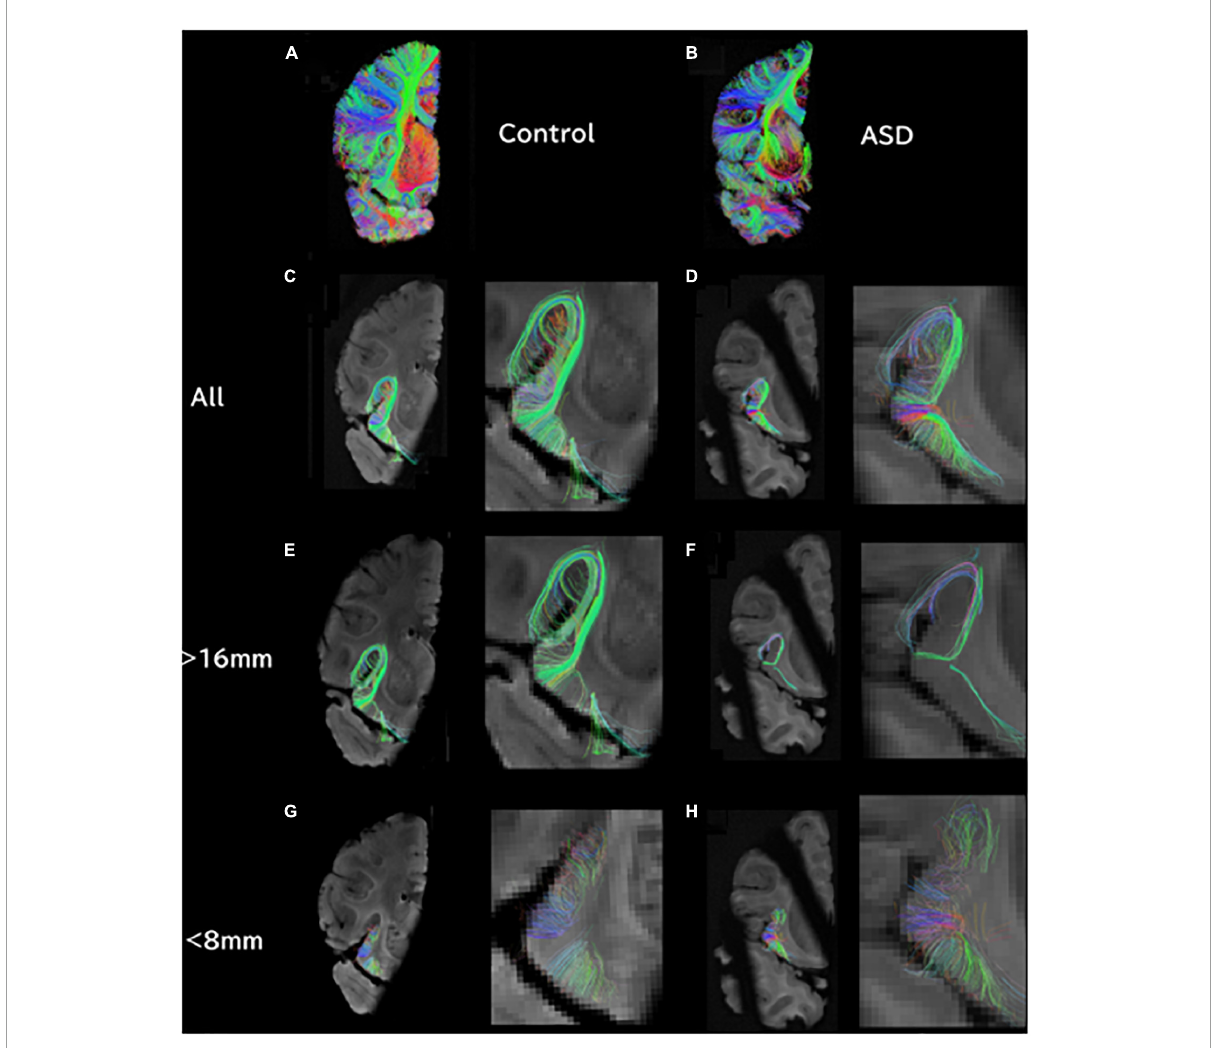
FIGURE1 At the level of the insula/thalamus, longer tractography pathways are decreased and shorter pathways are increased in ASD. (A) Overall tractography pathways in right hemisphere of Control (#6032; 4 years and 51 days old). (B) Overall tractography pathways in right hemisphere of a brain diagnosed with ASD (#5308; 4 years and 183 days old). (C) Tractography pathways from/to the insula at level of insula/thalamus in control. (D) Tractography pathways from/to the insula at level of insula/thalamus in ASD. (E) Long tractography pathways ( > 16 mm) from/to the insula of control. (F) Long tractography pathways ( > 16 mm) from/to the insula of ASD. (G) Short tractography pathways ( < 8 mm) within the insula/thalamus of control. (H) Short tractography pathways ( < 8 mm) within the insula/thalamus of